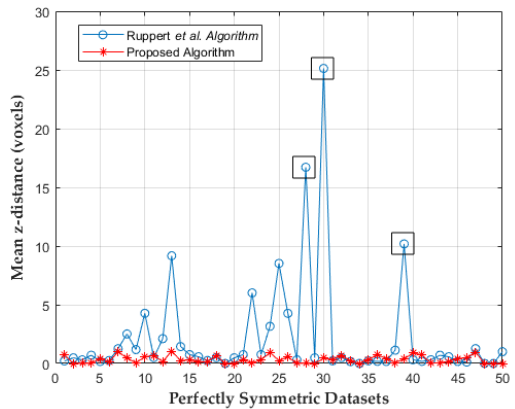
Figure 10. Average z -distances of perfectly symmetric datasets ( z -distances indicated by the square are not included for mean z -score calculation).